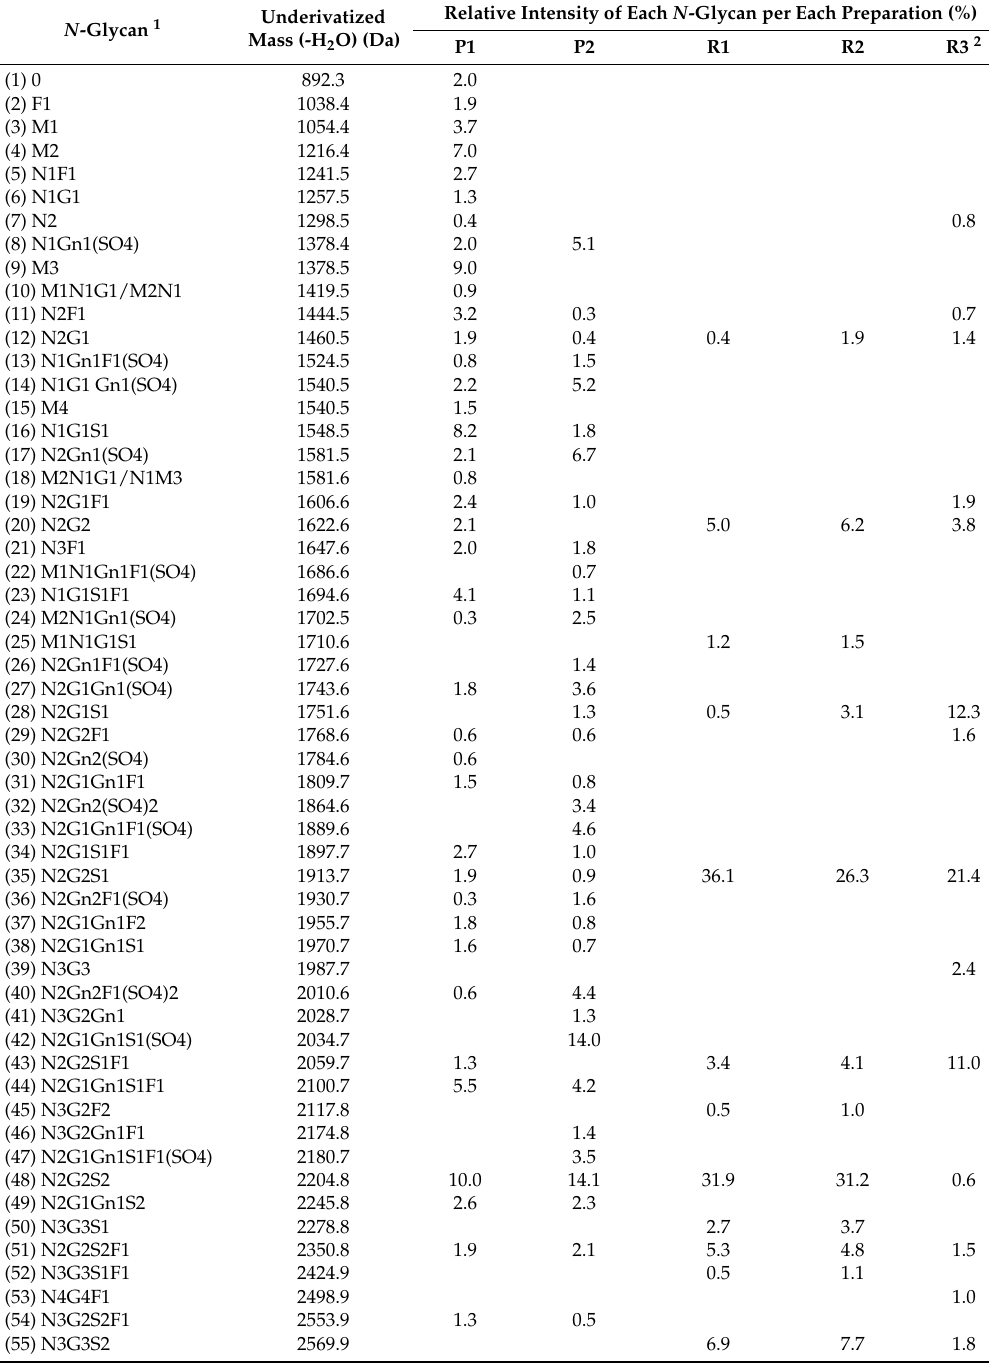
Table 1. Different N -glycan structures and relative intensities of two native and three recombinant preparations of human thyrotropin